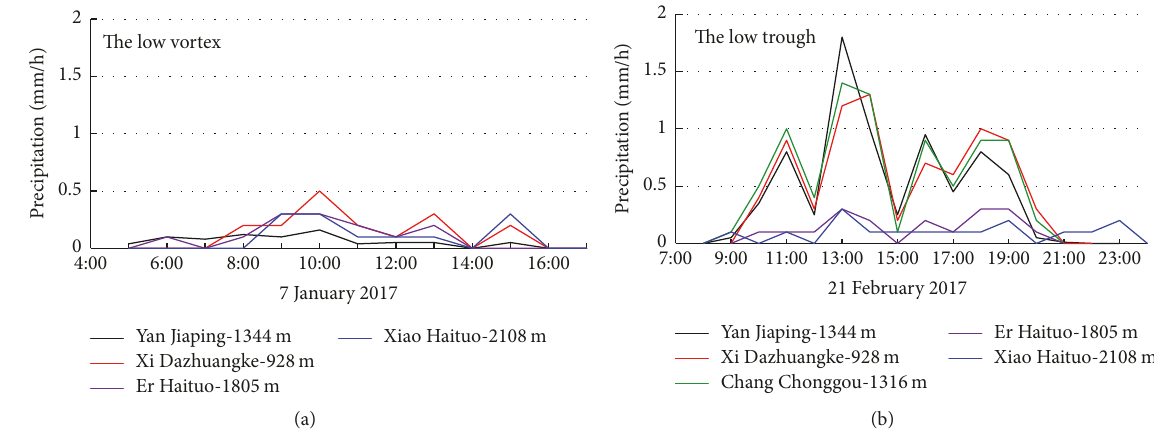
Figure 3: Distribution of precipitation rates at different altitudes under typical low vortex (case 9, (a)) and low trough (case 11, (b)) in the Haituo